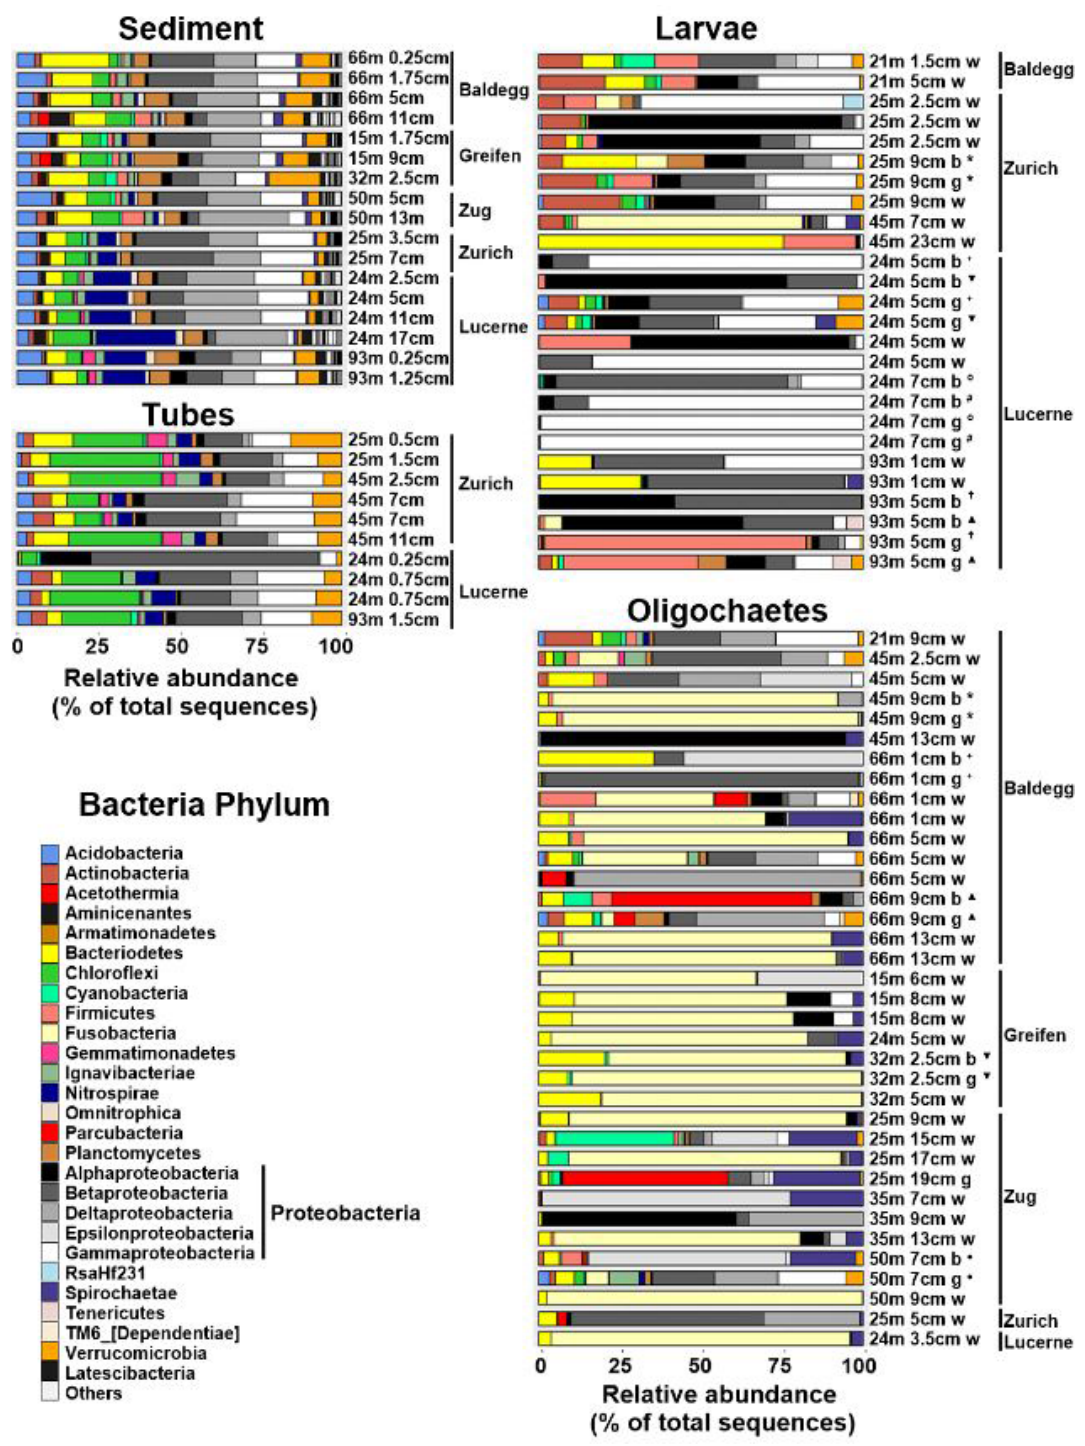
Figure 6. Relative abundances of Bacteria at the phylum level (Proteobacteria at class level) based on 16S rRNA gene sequences. Sequences were obtained from 17 sediment, 10 chironomid larval tube, 26 chironomid larvae ( N body = 7, N gut = 7, N whole = 12), and 36 oligochaete ( N body = 5, N gut = 6, N whole = 25) samples. Station and sample IDs are indicated by sample names, which indicate station water depth ( m ) , sediment depth ( cm ) , and portion of macrofaunal body analyzed (w = whole specimen, g = gut, b = body). Bodies and guts of the same specimens are marked by the same symbols. All sediment 16S rRNA gene sequence data are from Han et al. (2020).